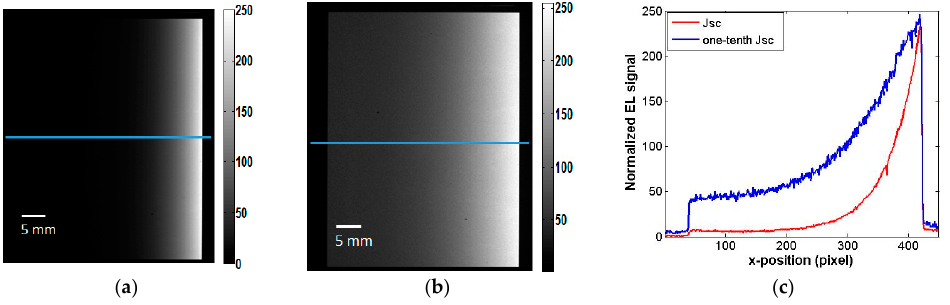
Figure 9. EL images of TF-1 module at two different current levels: ( a ) J sc ; and ( b ) one-tenth J sc ; along with line scans of EL intensity across the cell width ( c ).